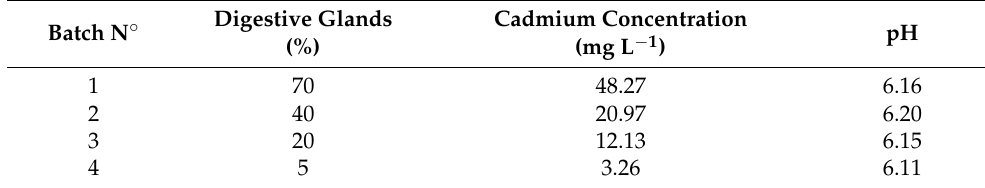
Table 1. Batches of giant squid hydrolysate (GSH) elaborated with different proportions of digestive glands at different production dates (weekly during May) and the resulting concentration of cadmium and pH of each